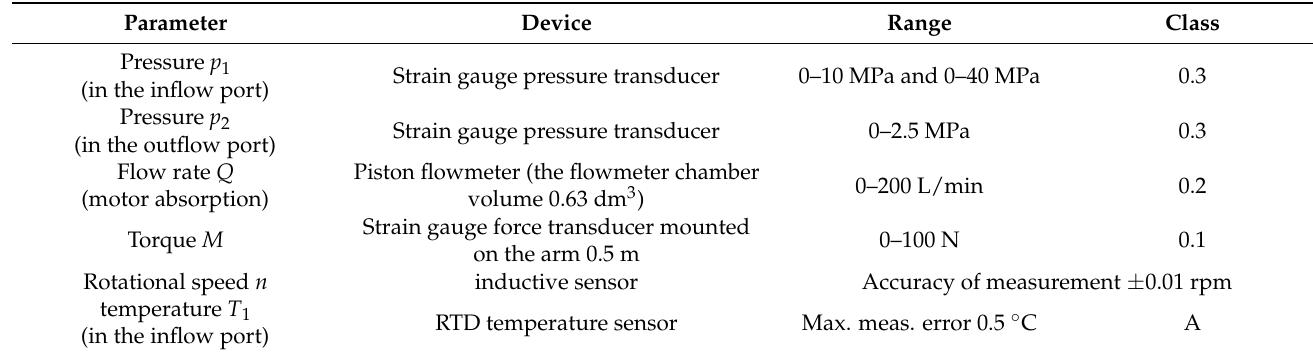
Table 1. Parameters of the tested motor.